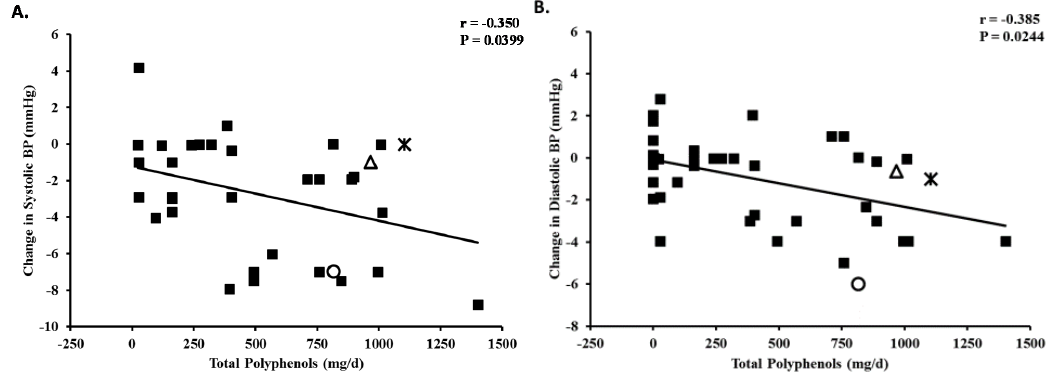
Figure 2. Dose-response for polyphenol-containing foods and beverages on systolic blood Figure 2. Dose ‐ response for polyphenol ‐ containing foods and beverages on systolic blood Figure 1. Polyphenol ‐ FMD dose ‐ response for polyphenol ‐ containing foods and beverages. The Figure 2. Dose ‐ response for polyphenol ‐ containing foods and beverages on systolic blood relative change in FMD for each study was calculated as: (Follow ‐ up FMD − Baseline FMD)/Baseline pressure ( A ) and diastolic blood pressure ( B ). Regression equations: Change in Systolic BP = (Total Figure 1. Polyphenol ‐ FMD dose ‐ response for polyphenol ‐ containing foods and beverages. The FMD. Regression equation: Relative Change in FMD = (Total polyphenols/d × 0.00071) + 0.0187. polyphenols/day × − 0.00294) − 1.2585. Change in Diastolic BP = (Total polyphenols/day × − 0.00205) − relative change in FMD for each study was calculated as: (Follow ‐ up FMD − Baseline FMD)/Baseline Concord grape juice: 0.2279. Concord grape juice: FMD. Regression equation: Relative Change in FMD = (Total polyphenols/d × 0.00071) + 0.2279. Concord grape juice: